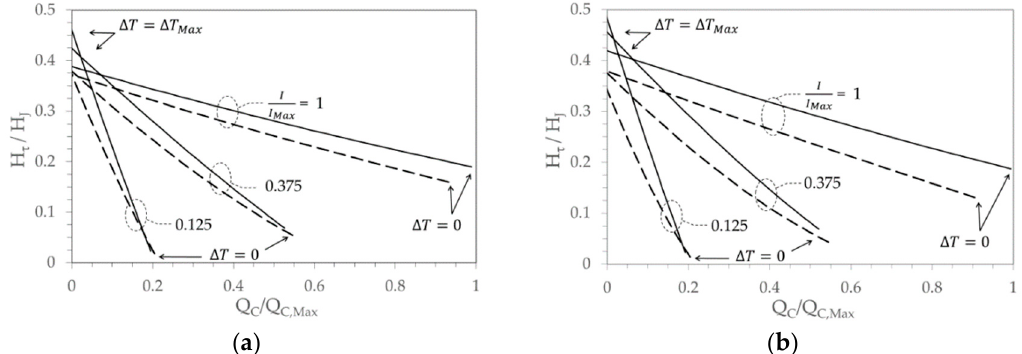
Figure 8. Cold side: ratio between Thomson heat and Joule effect versus the relative cooling capacity, solid line case (i), dashed line case (ii). ( a ) T H = 298.15 K ; ( b ) T H = 323.15 K .